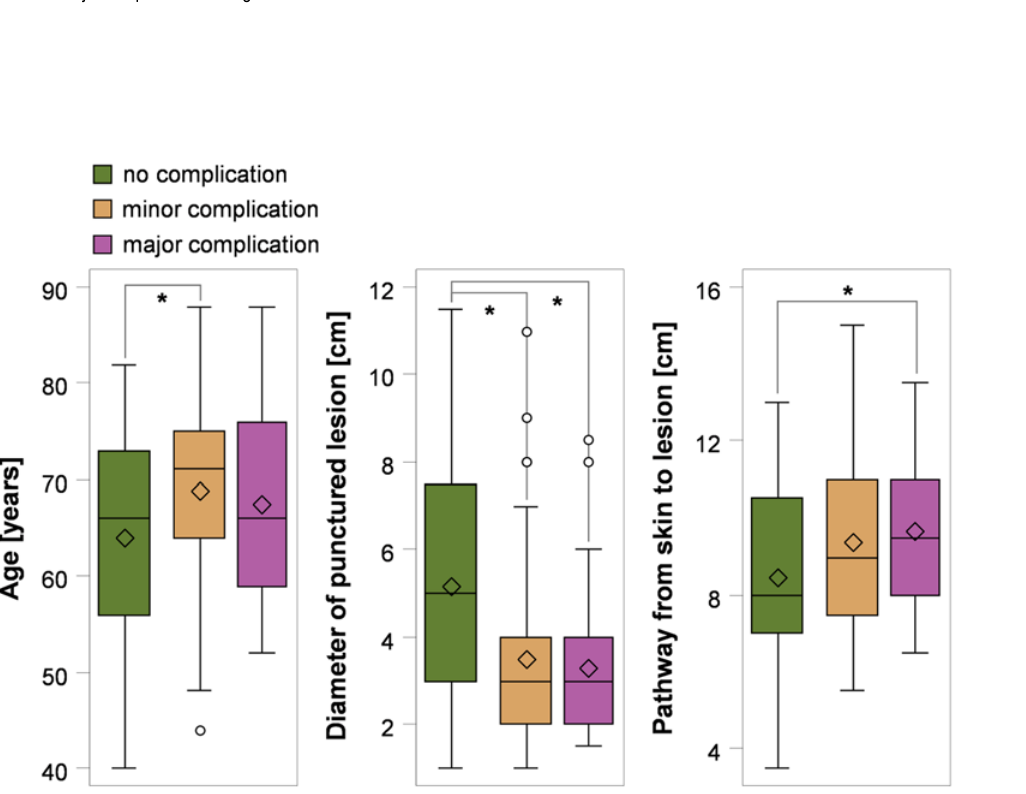
Fig 2. Predictors of complication rates of CT-guided percutaneous transthoracic lung biopsies of pulmonary tumors according to patient age, lesion diameter, and length of interventional pathway ( * p < 0.05).